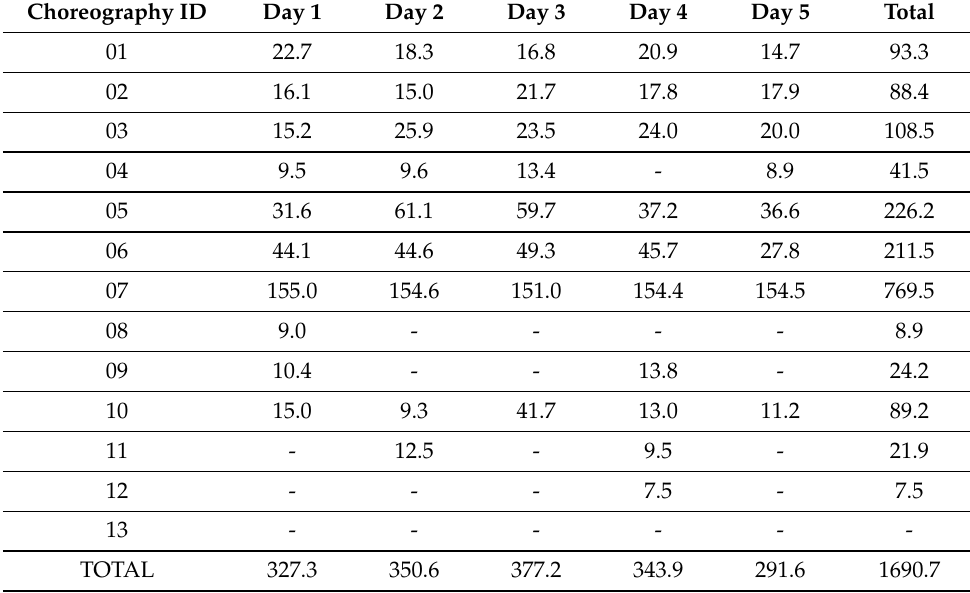
Table 10. Example of daily consumption, in kWh, per